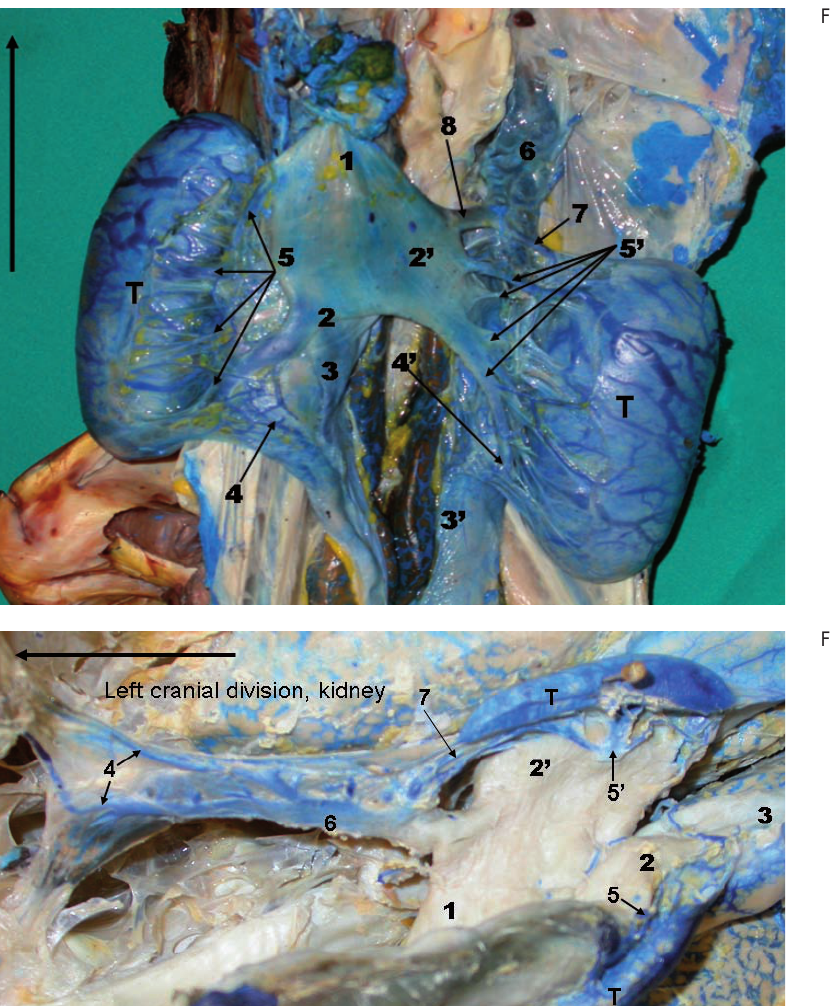
FIG. 4 Ventral view of the thoraco-ab- dominal region of a pre-puber- tal bird illustrating the testes (T) and associated veins. V. cava caudalis (1), Vv. iliacae communes dextra et sinistra (2, 2’), V. renalis caudalis dex- tra (3), Vv. testiculares dextra et sinistra (5, 5’), V. adrenalis sinistra (6). Note the branches from the latero-dorsal body wall (4) draining into the adre- nal vein (6) as well as a testic- ular vein (7) that drains the left testis into the left common iliac vein via the adrenal vein. Arrow top left indicates caudo-cranial direction. Latex